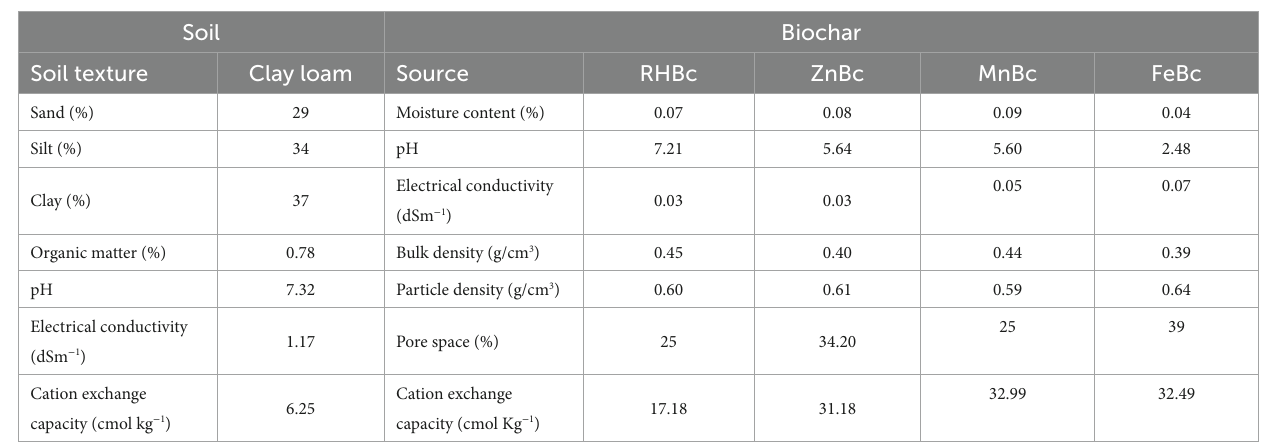
TABLE 5 Characterization of bhal soil and all sorts of